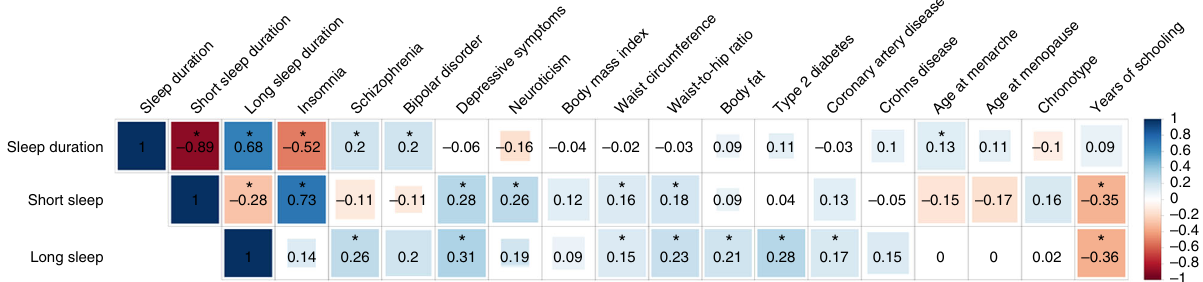
Fig. 3 Shared genetic architecture between sleep duration and behavioral and disease traits. Linkage disequilibrium (LD) score regression estimates of genetic correlation ( r g ) were obtained by comparing genome-wide association estimates for sleep duration with summary statistics estimates from 224 publically available genome-wide association studies (GWASs). Blue indicates positive genetic correlation and red indicates negative genetic correlation; r g values are displayed for signi fi cant correlations. Larger colored squares correspond to more signi fi cant P values, and asterisks indicate signi fi cant ( P < 2.2 × 10 − 4 ) genetic correlations. All genetic correlations in this report can be found in tabular form in Supplementary Data